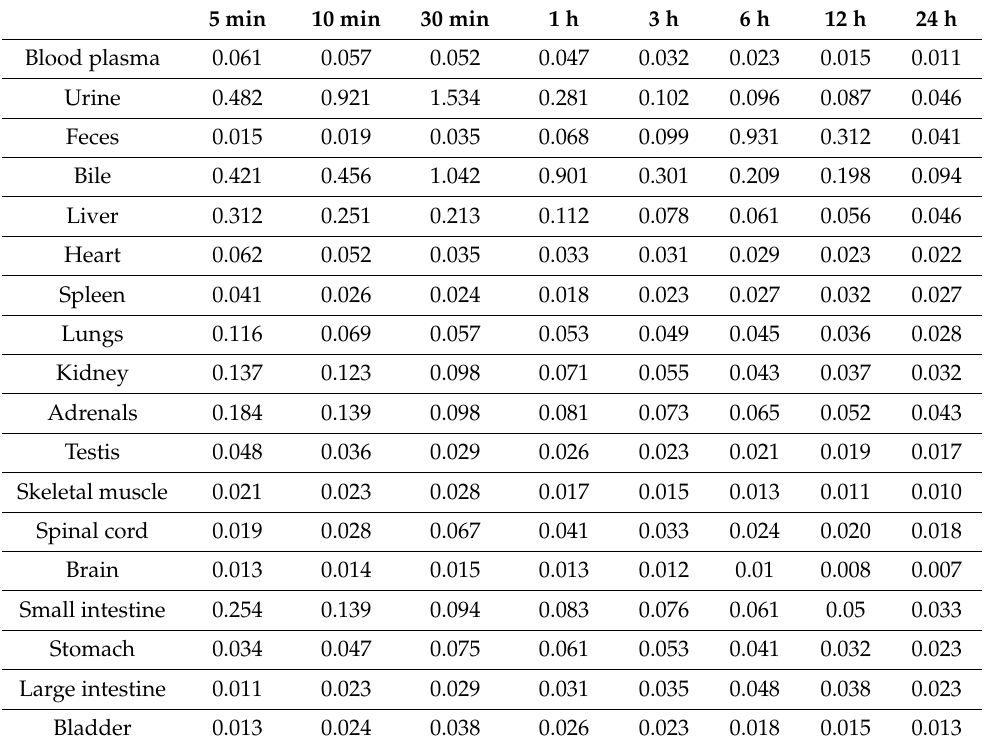
Table 3. The effect of 3 H- Achyranthes bidentata ecdysterone on the quantitative distribution of different tissues in different tracking phases of mice (mean, n = 5) expressed in μg g − 1 (translated from Wu et al. [124]).